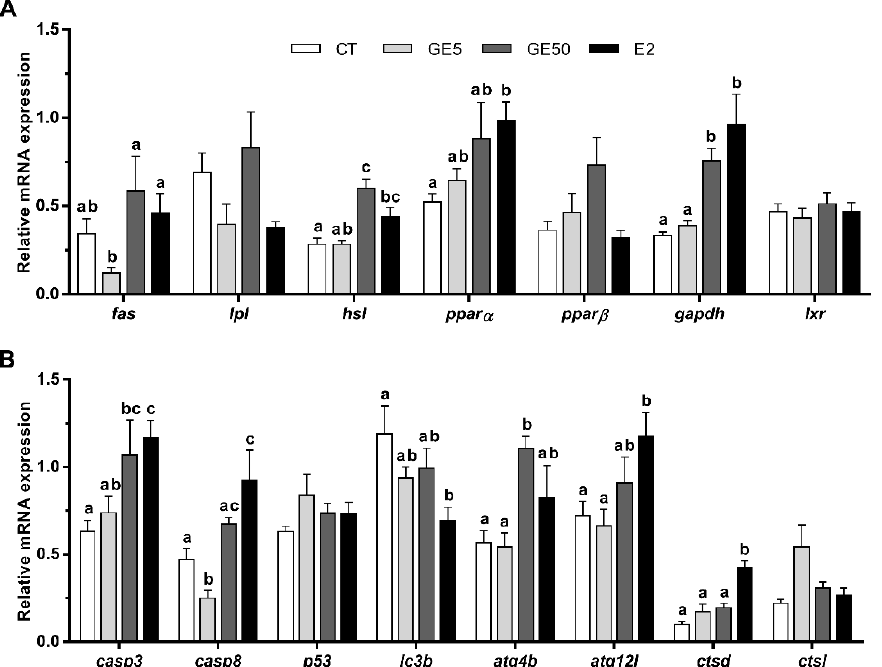
Figure 6. In vivo e ff ects on rainbow trout intraperitoneally injected with vehicle (DMSO diluted 1:3 in sesame oil) as CT, GE 5 µ g / g, GE 50 µ g / g, or E2 5 µ g / g over the expression of lipid metabolism, and apoptosis- and autophagy-related genes in liver. Relative mRNA expression normalized to ubq and β -actin of ( A ) fas , lpl , hsl , ppar α , ppar β , gapdh , and lxr , and ( B ) casp3 , casp8 , p53 , lc3b , atg4b , atg12l , ctsd , and ctsl . Data are shown as mean + SEM ( n = 6–9). Significant di ff erences among treatments for each gene were determined by one-way ANOVA and are indicated by di ff erent letters ( p < 0.05). When two groups share at least one letter, they are not statistically di ff erent. CT: Control; GE: Genistein; E2: 17 β